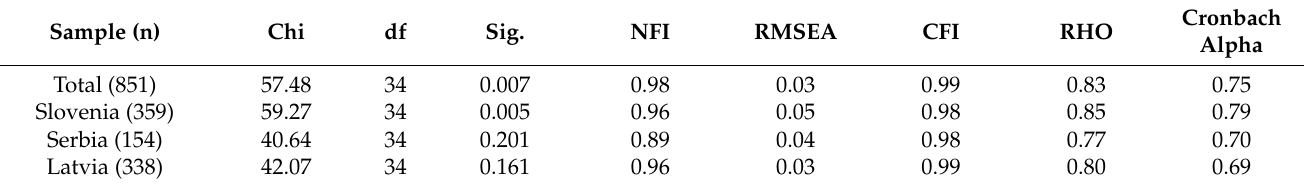
Table 4. Structural equation modeling results (goodness-of-fit and